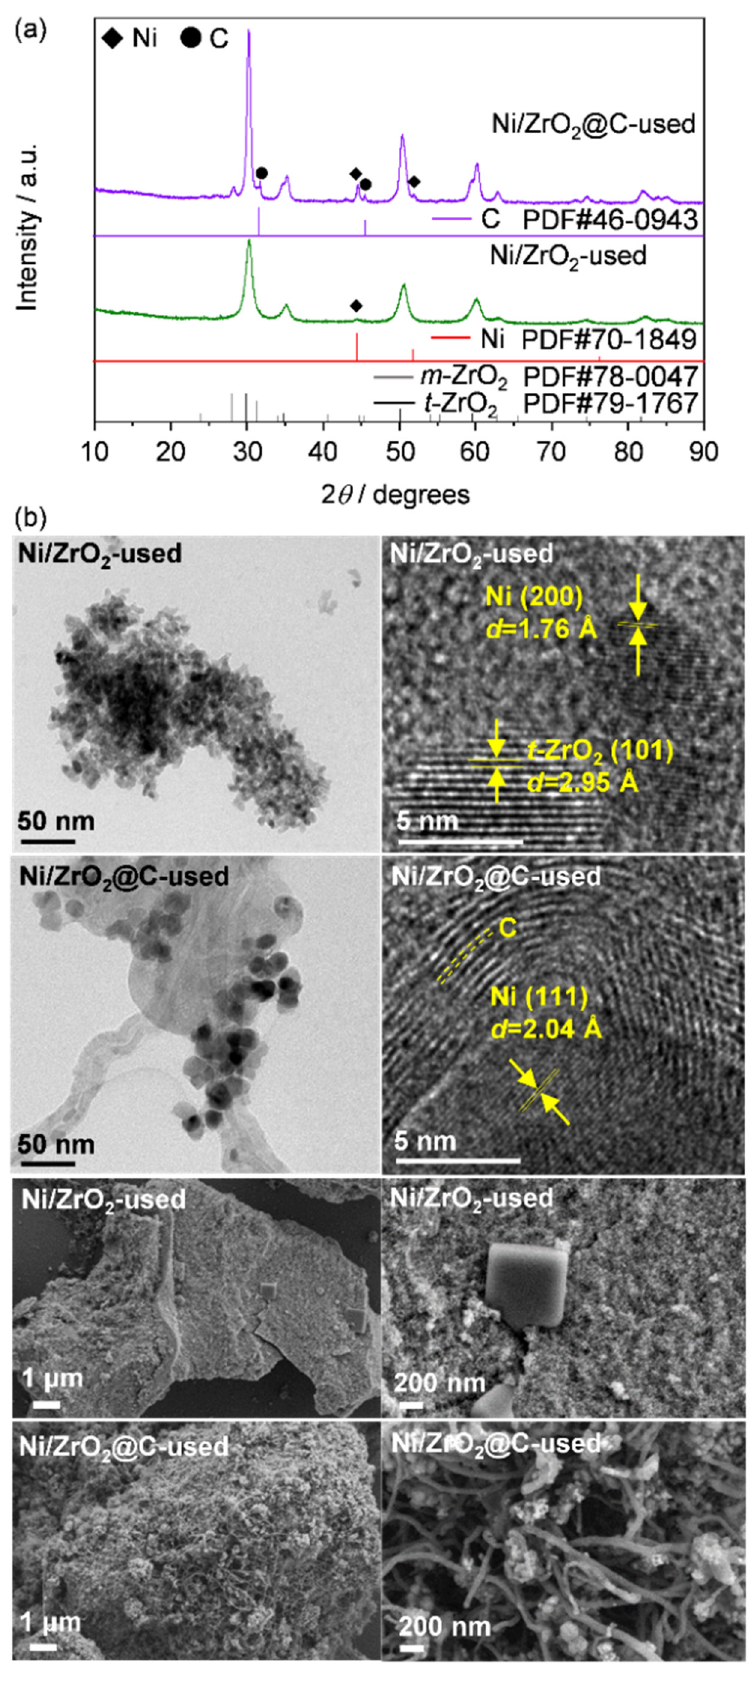
Figure 6. ( a) XRD, ( b ) TEM and SEM images of Ni/ZrO 2 and Ni/ZrO 2 @C after the stability tests.